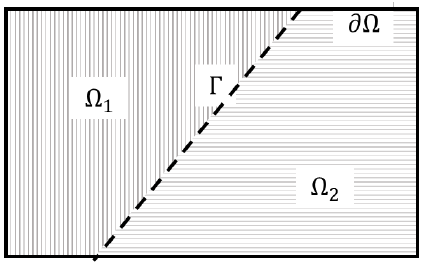
Figure 5. Sub-decomposition of the domain.